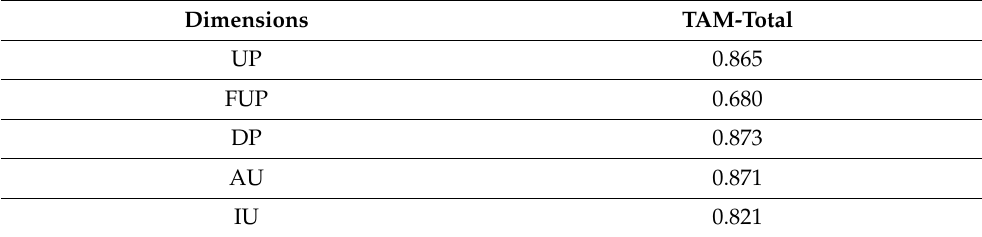
Table 6. Correlations between the TAM and the dimensions that comprise